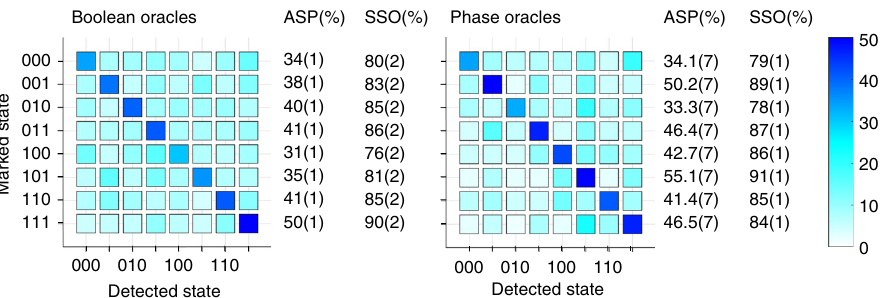
Fig. 3 Single-solution algorithm. Results from a single iteration of a single-solution Grover search algorithm performed on a 3-qubit database. Data for the Boolean oracle formulation are shown on the left, and data for the phase oracle formulation are shown on the right. The plots show the probability of detecting each output state. All values shown are percents, with a theoretical ASP of 78.1% and theoretical SSO of 100%. Data are corrected for average SPAM errors of